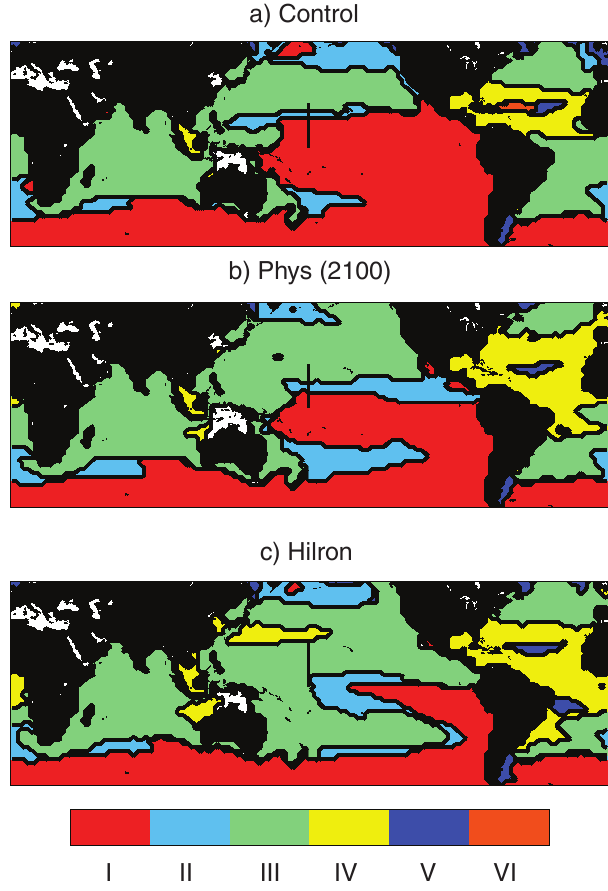
Figure 3. Subtropical/tropical provinces in the numerical model, defined only by whether diazotrophs and non-diazotrophs co-exist and by which nutrient limits the phytoplankton (first three lines of Table 5) for (a) pre-industrial conditions (experiment Control ); (b) Phys at 2100; (c) HiIron . Note unshaded regions (except for Mediterranean which is not resolved in this setup) did not fit into the six province categories. Black line in Pacific indicates the tran- sect shown in Figs. 4 and